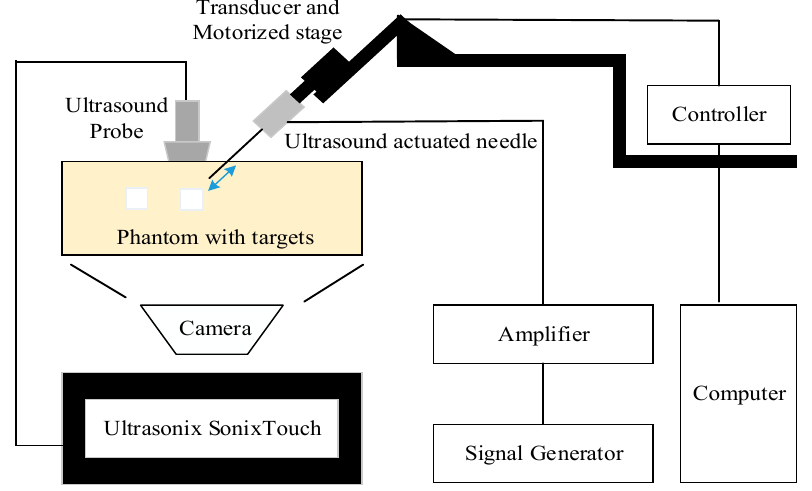
Figure 2. Diagram of experimental setup for the needle accuracy test.